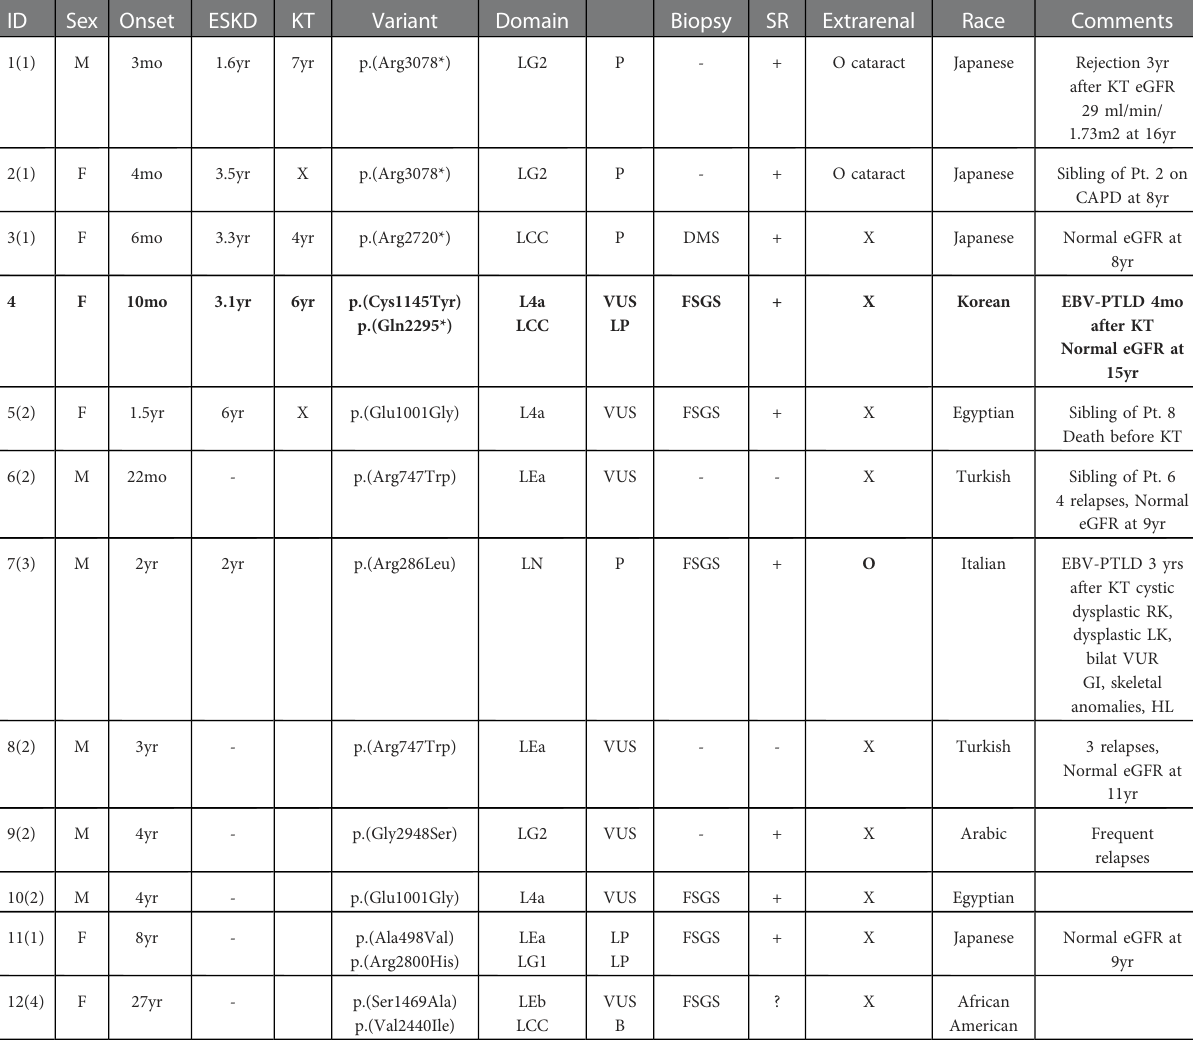
TABLE 1 Characteristics of reported patients with LAMA5 mutation and nephrotic phenotype